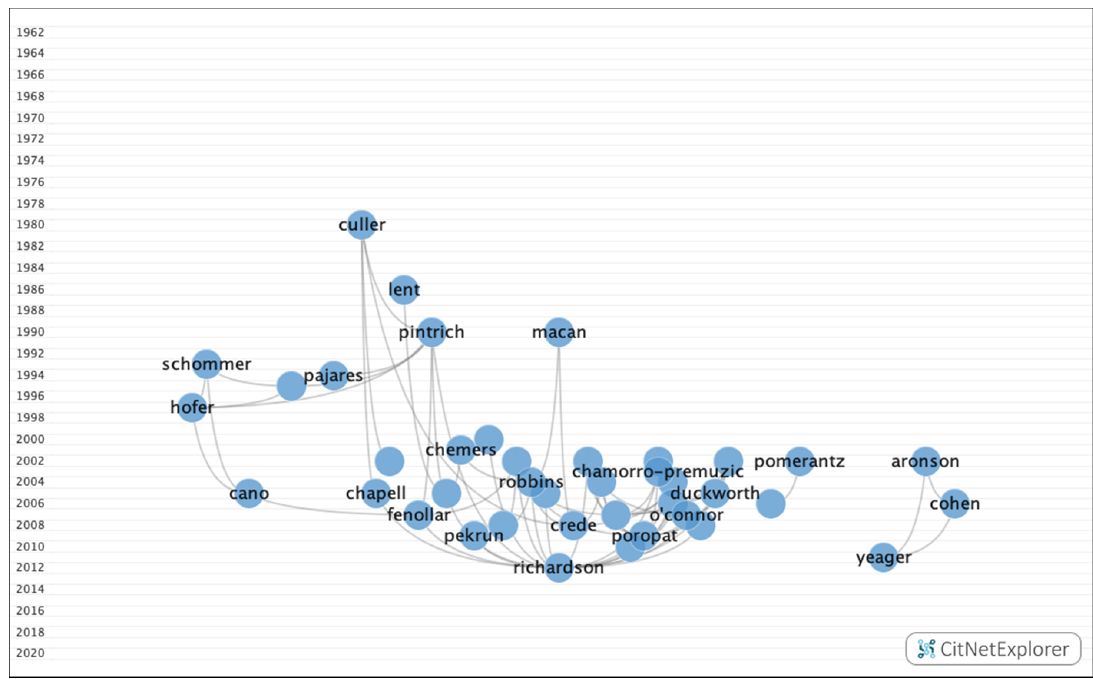
Figure 7. Group 1 citation network.